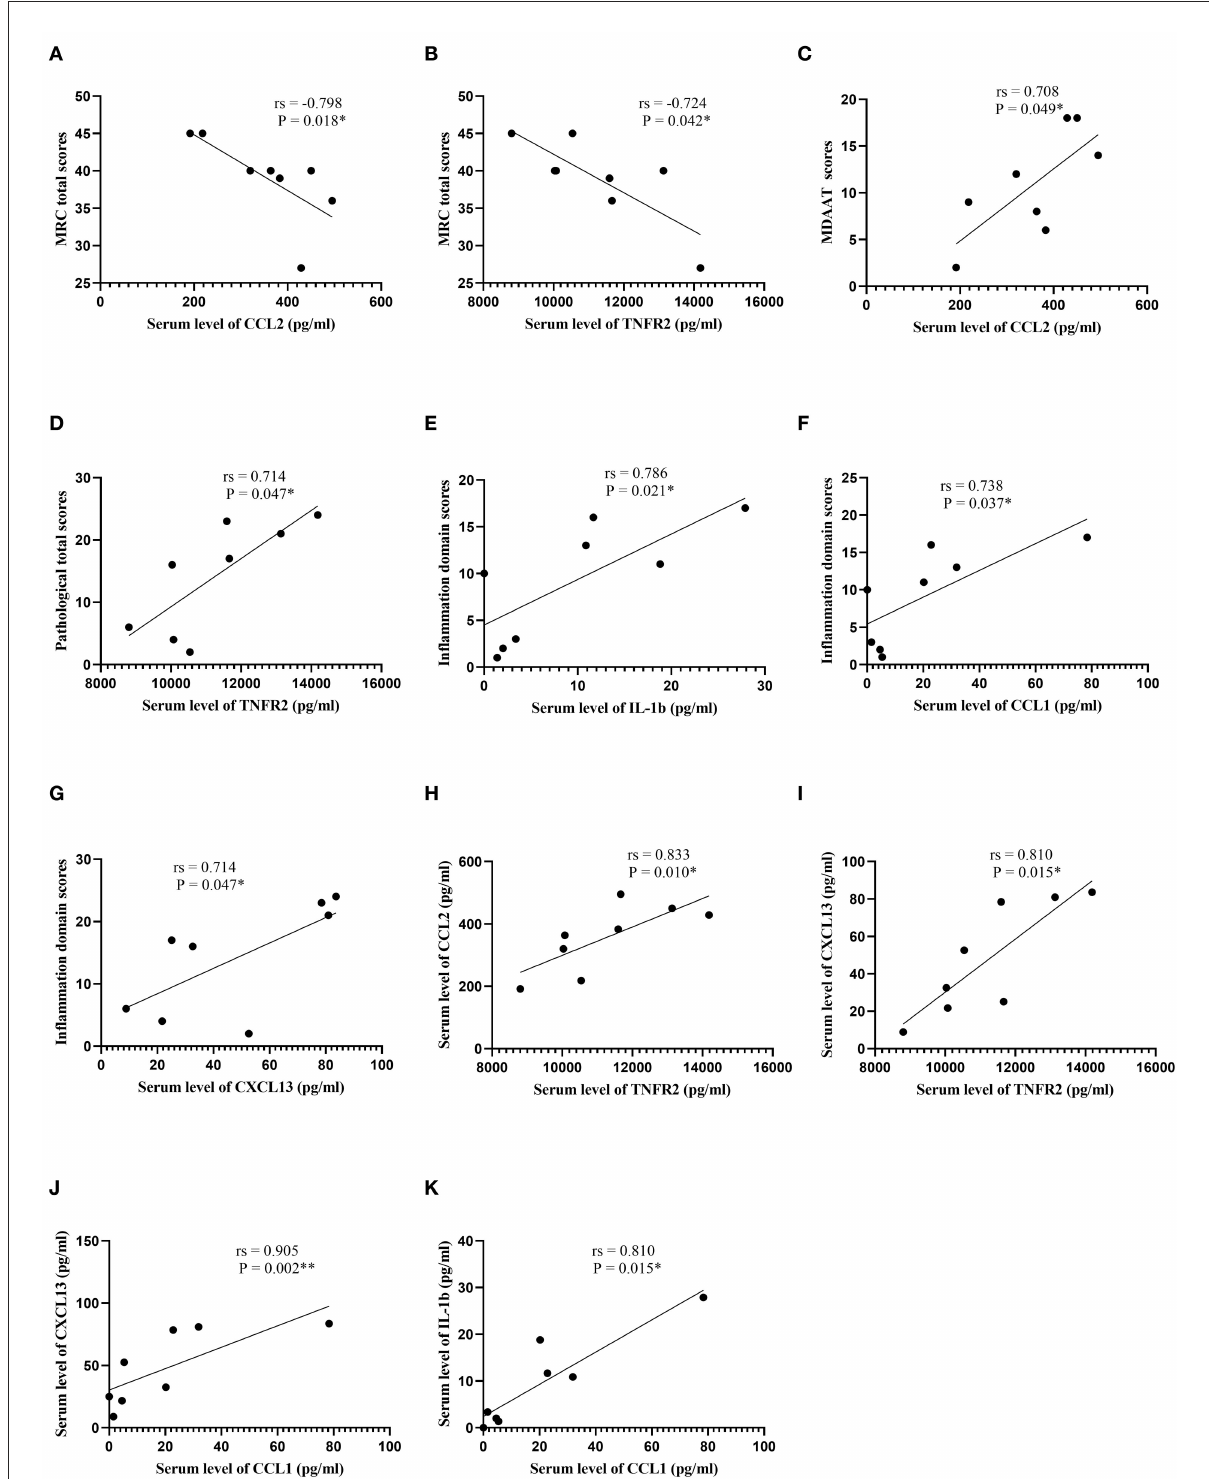
FIGURE3 Correlation analysis in patients with dermatomyositis. (A) Correlation analysis between serum CCL2 levels and MRC total scores. (B) Correlation analysis between serum TNFR2 levels and MRC total scores. (C) Correlation analysis between serum CCL2 levels and MDAAT scores. (D) Correlation analysis between serum TNFR2 levels and pathological total scores. (E) Correlation analysis between serum IL-1b levels and inflammation domain scores. (F) Correlation analysis between serum CCL1 levels and inflammation domain scores. (G) Correlation analysis between serum CXCL13 levels and inflammation domain scores. (H) Correlation analysis between serum TNFR2 levels and serum CCL2 levels. (I) Correlation analysis between serum TNFR2 levels and serum CXCL13 levels. (J) Correlation analysis between serum CCL1 levels and serum CXCL13 levels. (K) Correlation analysis between serum CCL1 levels and serum IL-1b levels. CCL, C-C motif chemokine ligand; MRC,